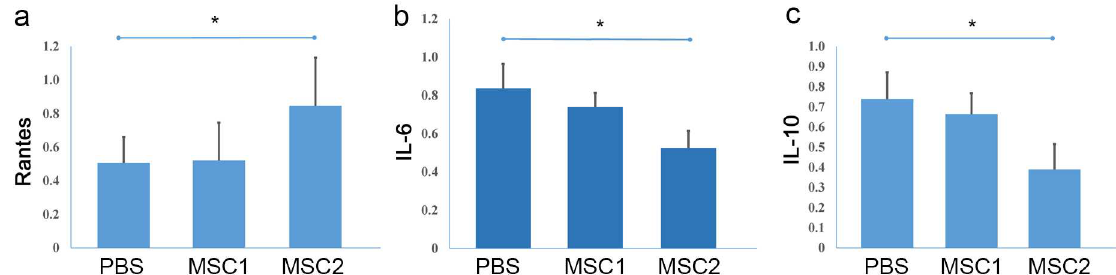
Fig 4. Quantitative analysis of cytokine levels in sera. Serum levels of (a) Rantes, (b) IL-6 and (c) IL-10 in SD rats of the three groups were evaluated at day 135 followingOVX. Data was presented as mean ± SD (n = 8). Significant level was taken at p <